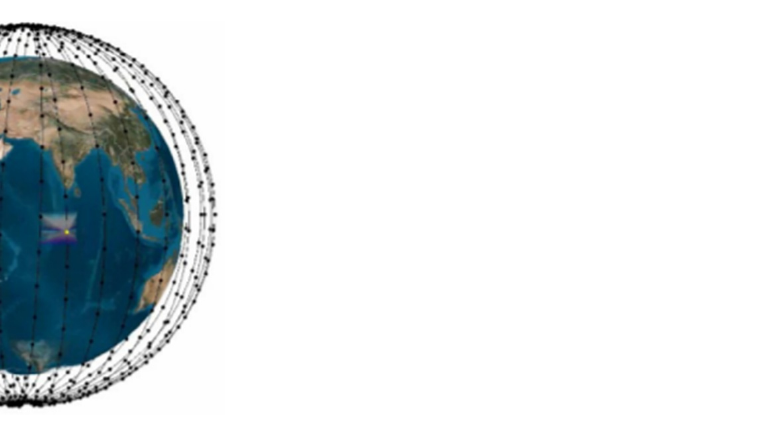
Figure 2. Constellation pattern of OneWeb system: 648 satellites distributed across 12 circular orbital planes at an altitude of 1200 Km; each plane inclined at 87°.